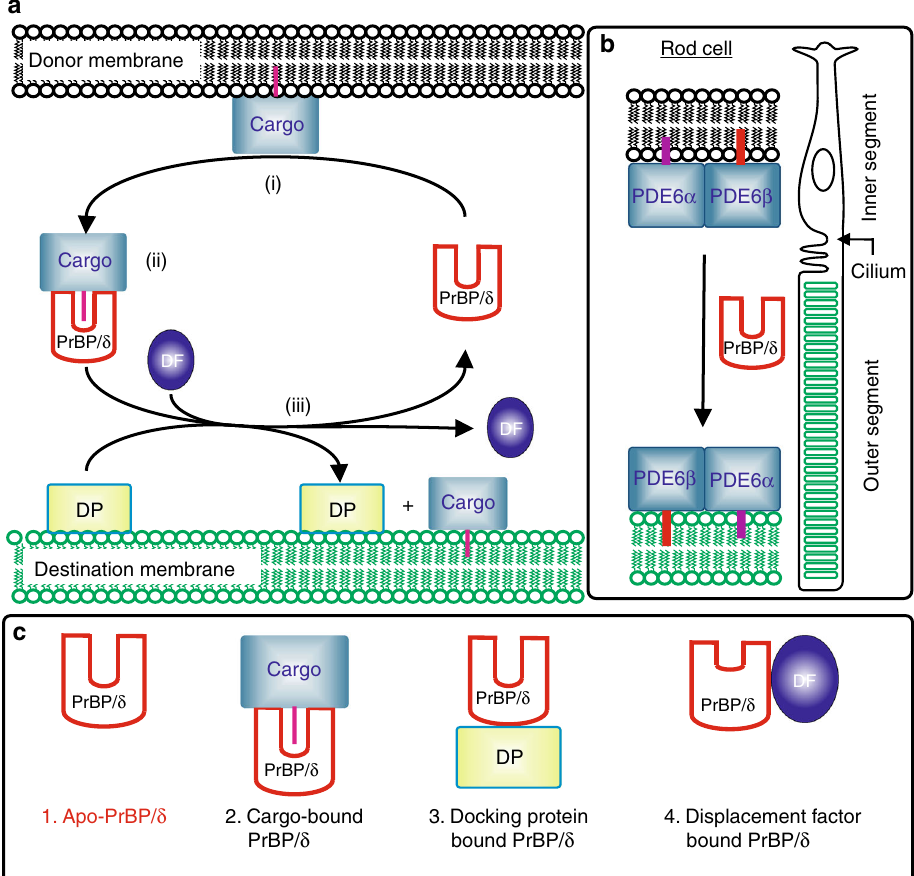
Fig. 1 Overview of interactions of the solubilization factor PrBP/ δ . a Schematic model of the PrBP/ δ traf fi cking cycle. The transport of prenylated proteins (cargo) is initiated upon (i) dissociation of the cargo from the donor membrane by interaction with PrBP/ δ (red). (ii) Cargo-bound PrBP/ δ then diffuses through the cytoplasm, as the hydrophobic isoprene moiety of the cargo is buried in a cavity of PrBP/ δ . Subsequent targeting of cargo-bound PrBP/ δ to the destination compartment is achieved by interaction of PrBP/ δ with docking proteins (DP) that are peripherically bound to the destination membrane. Additional GTP/GDP-binding proteins (dissociation factors, DF) are required to dissociate the cargo from PrBP/ δ which in turn allows (iii) release of the cargo into the membrane 6 . Eventually, the traf fi cking cycle closes when apo-PrBP/ δ diffuses back to the donor compartment. b Schematic representation of a rod photoreceptor cell. The rod cell consists of an inner segment (with the common cell compartments) and, connected by a cilium, an outer segment, which contains a stack of disc membranes and the signaling proteins. Binding of PrBP/ δ to newly synthesized, prenylated signaling proteins such as PDE6 allows their transport to the outer segment. c Comparison of selected crystal structures of PrBP/ δ . Beside the crystal structure of (1) apo-PrBP/ δ presented in this study, several PrBP/ δ -complexes are structurally characterized, including (2) cargo-bound PrBP/ δ (e.g., farnesylated Rheb (PDB entry 5T3G); farnesylated INPP5E-peptide (PDB entry 5F2U); farnesylated K-RAS4B (PDB entry 5TAR); geranylgeranylated PDE6C-peptide (PDB entry 5E8F)), (3) PrBP/ δ bound to docking protein RPGR (PDB entry 4JHP) and (4) PrBP/ δ bound to the displacement factor Arl2 (PDB entry 1KSG). Crystal structures of (1) and (2) can be assigned to the traf fi cking cycle ( a ), whereas (3) and (4) are part of the dissociation step of the cargo into the destination Comparison of various functional states of PrBP/ δ . The obtained structure of apo-PrBP/ δ (PDB entry 5T4X) with its preshaped cavity in open conformation was compared with examples of known PrBP/ δ conformations from earlier published co-crystal structures (Fig. 2).